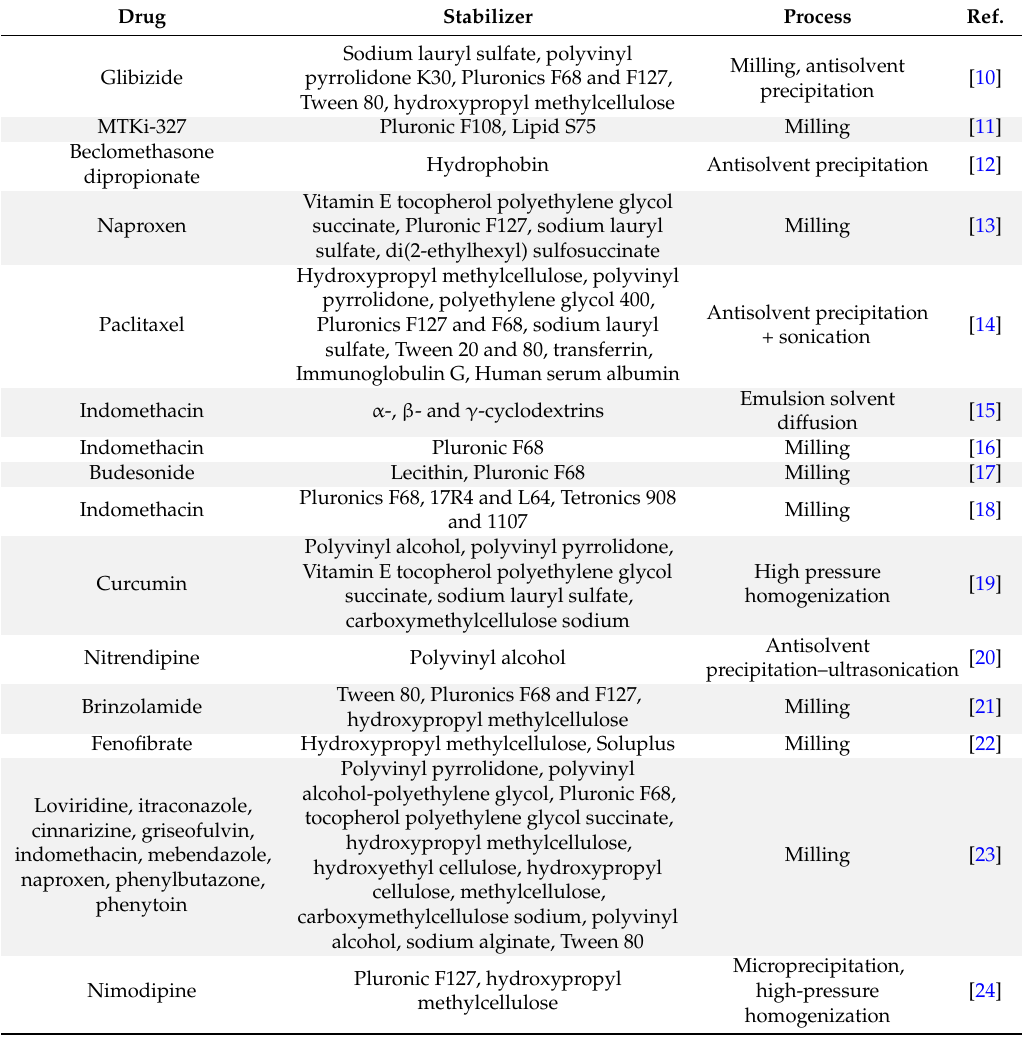
Table 1. Examples of drug/stabilizer combinations in nanocrystal